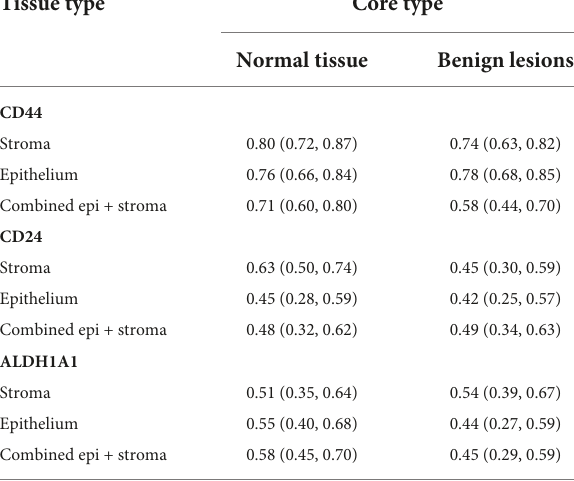
TABLE 3 Intra-class correlation in marker expression across available cores for a woman, by core and tissue type as assessed by Definiens. Tissue type